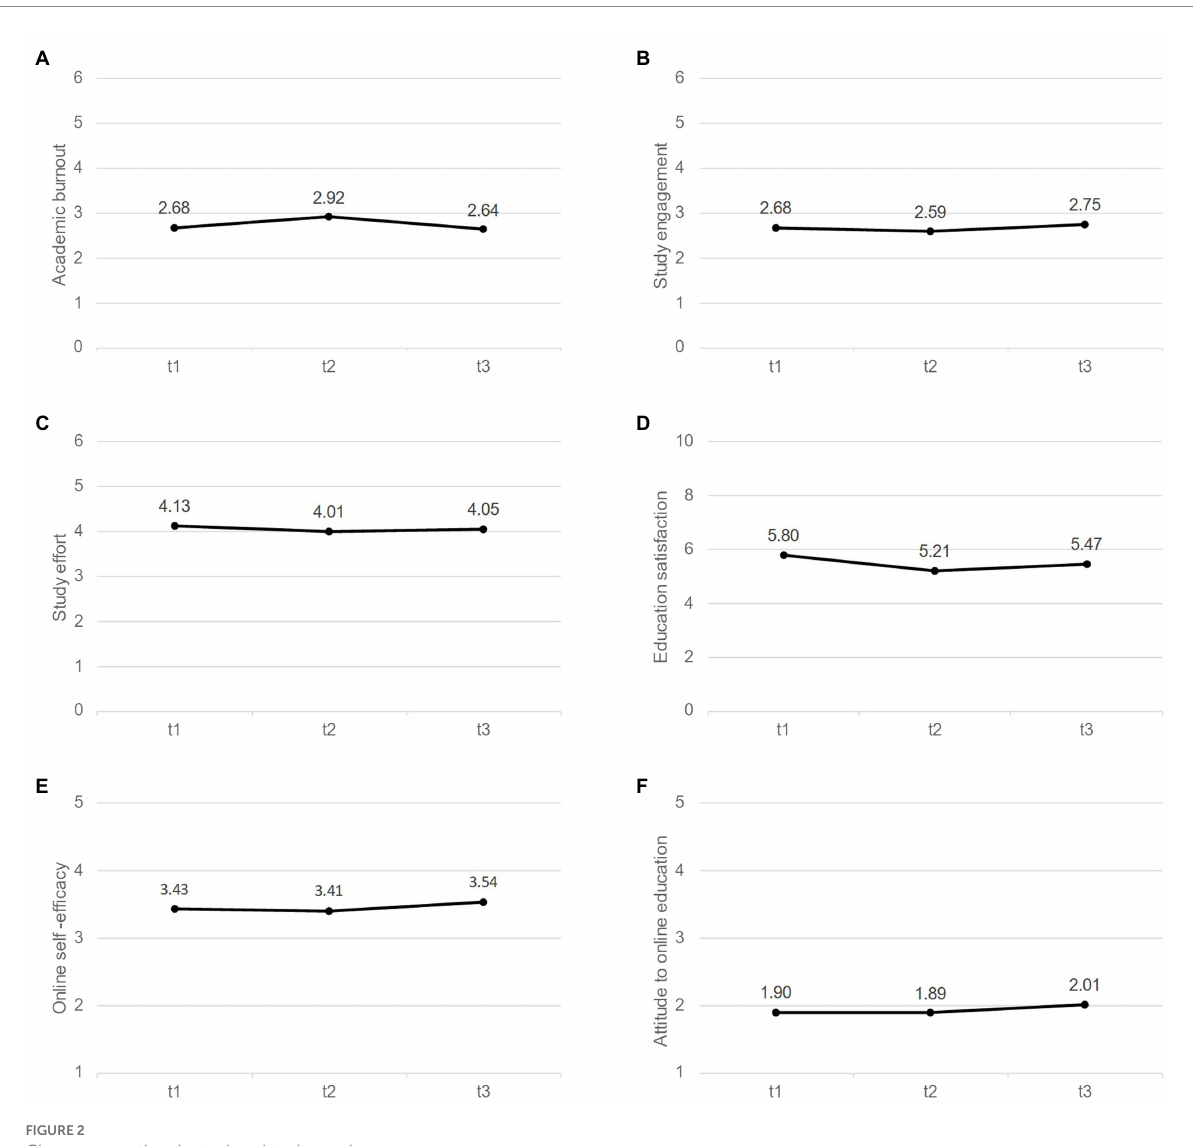
FIGURE 2 Changes over time in study-related